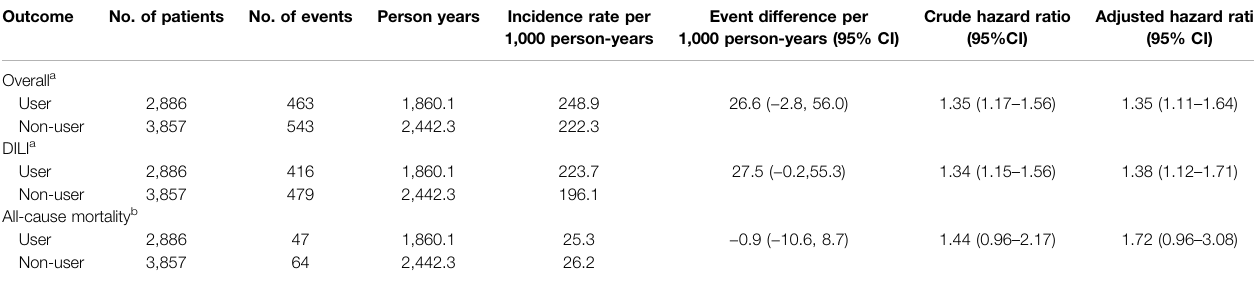
TABLE 3 | Crude and adjusted hazard ratios for the association between the use of liver-protective agents and the risk of the study outcomes.